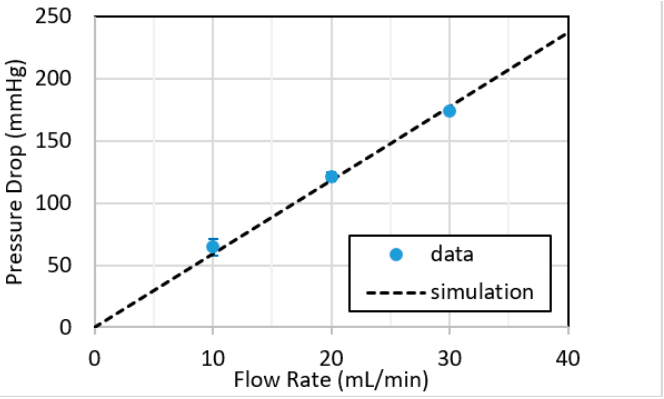
Figure 6. Measured pressure drop across RAD2v2 devices ( n = 4) in mmHg as a function of blood flow rate in mL/min. Note that at 25 mL/min blood flow rate, the measured pressure drop is approximately 150 mm Hg, a value that includes the pressure drop of the device itself as well as the inlet and outlet tubing lengths connecting the oxygenator prototype to the circuit. Error bars indicate one standard deviation around the mean.